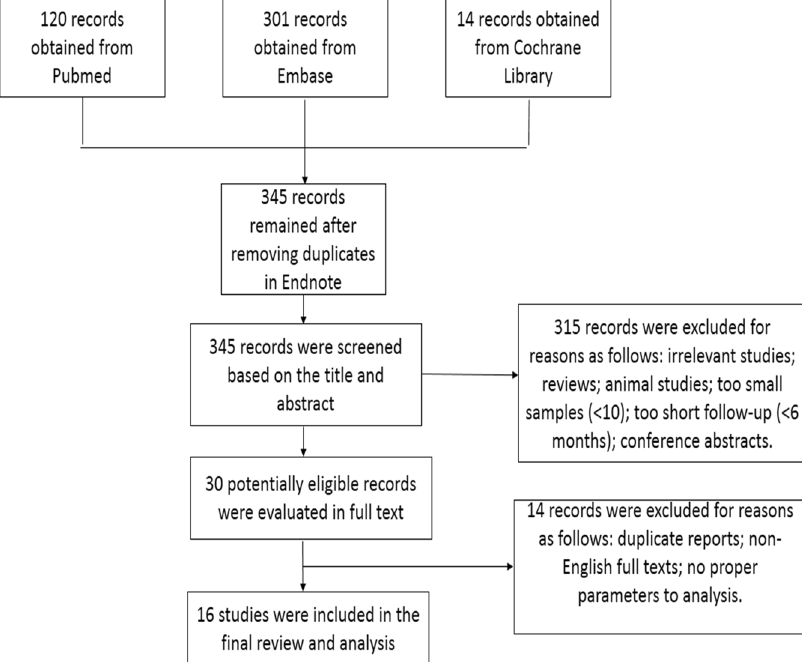
Figure 1. Flow chart of literature search.